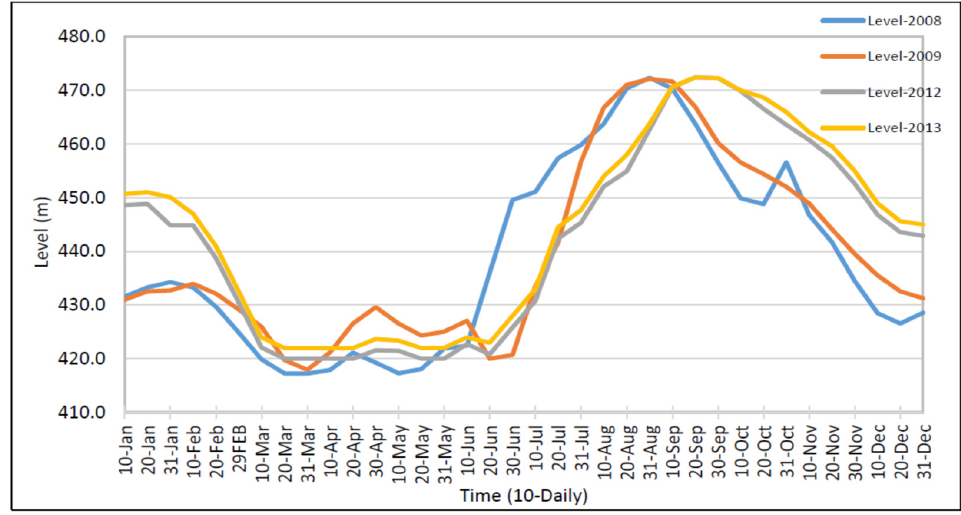
Figure 8. Tarbela Reservoir levels.